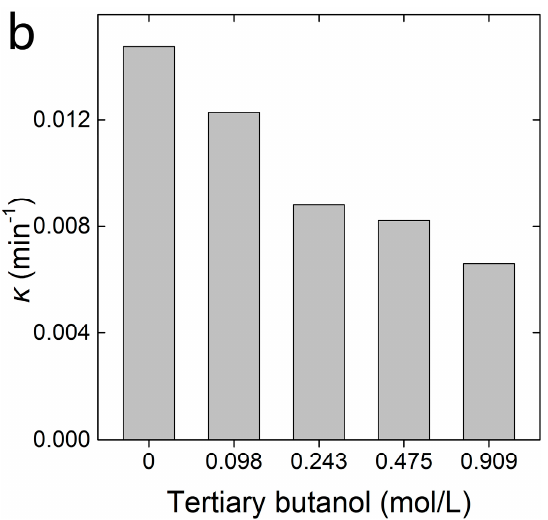
Figure 5. Resistance of the FTCNC-H 2 O 2 Fenton-like system against radical scavenger tertiary butanol. ( a ) ESR spectra of FTCNC-H 2 O 2 Fenton-like system at 5 and 10 min; ( b ) influence of tertiary butanol.